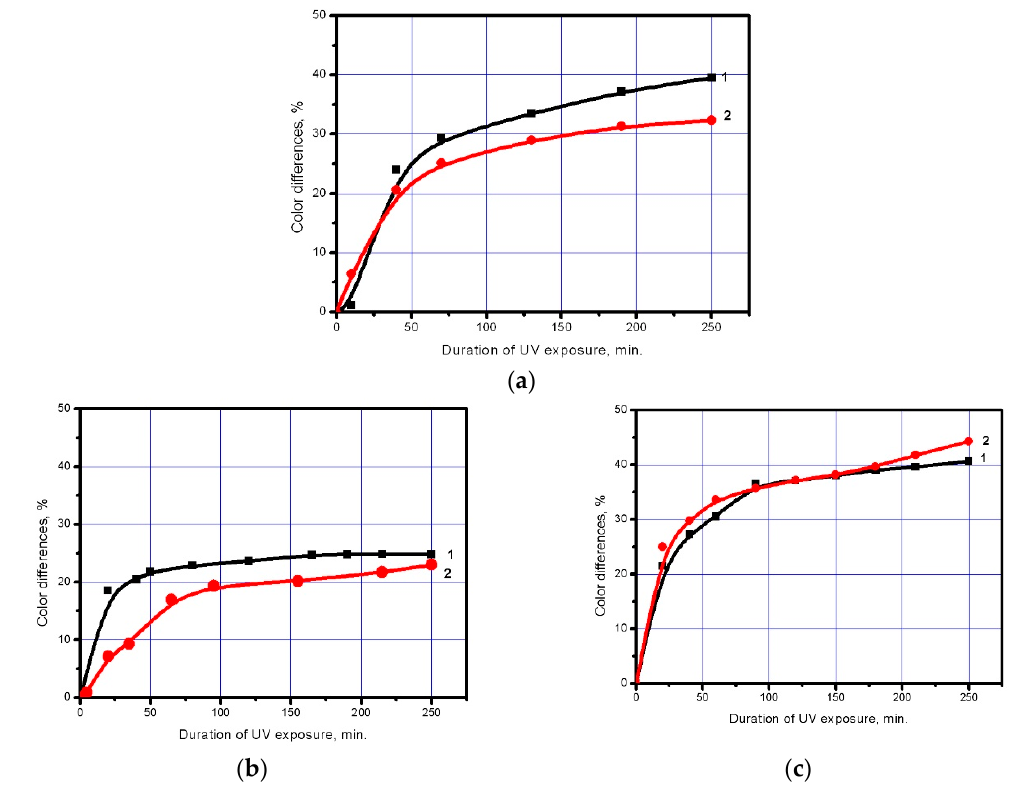
Figure 4. Colour differences in eosin for NaOH-activated (3.75 g/L) polyester fabric before it is subjected to abrasion (1) and after it (2). Fabric with a TiO 2 coating (8 g/cm 2 ) consisting of: ( a ) Undopednanoparticles; ( b ) Nanoparticles doped with iron; ( c ) Nanoparticles doped with silver.